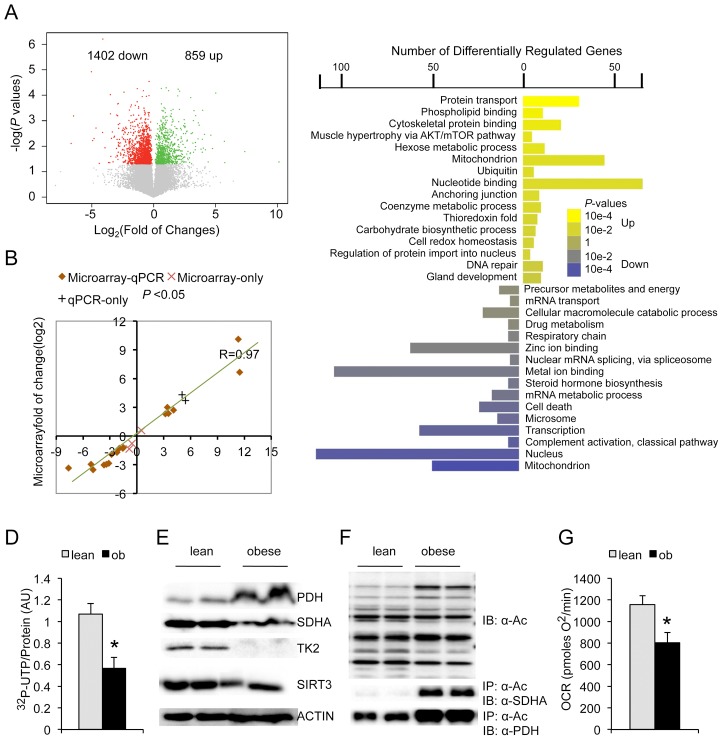
Genome-wide translational changes in the obese mouse liver.(A) Scatterplot of logP-values versus log2FC (fold of change, obese/lean). Green denotes genes up-regulated in the obese liver ER translatome while red denotes downregulation. (B) Differential regulation of transcripts as measured by microarray (Y-axis) and quantitative RT-PCR (X-axis) for 22 genes that were calculated as differentially regulated (student t-test, P<0.05) by either one or both methods. (C) Gene Ontology analysis of differentially regulated genes in the ER translatome of nonfasted lean and obese liver. X-axis denotes the number of genes categorized into each differentially-regulated function on the Y-axis. Color scale corresponds to logP-values converted to positive values for functional categories comprised of upregulated (obese/lean) genes. (D) Measurement of RNA synthesis in lean and obese primary hepatocytes based on 32P-UTP incorporation (t = 2 hours, n = 4, p<0.01, Student's t-test). (E) Immunoblot measurement of mitochondria protein expressions in the lean and obse mouse liver samples. (F) Immunoblot measurement of overall mitochondrial protein acetylation (IB: α-Ac, top panel) and the acetylation of the succinate dehydrogenase (IP: α-Ac; IB: α-SDHA, middle panel). Acetylation of the pyruvate dehydrogenase enzyme 1 (PDH-E1α) is shown (bottom panel) as a positive control for α-Ac immunoprecipitation as it is fully charged with acetyl-CoA under both lean and obese conditions. (G) Measurement of mitochondria oxygen consumption rate (OCR) for lean and obese primary hepatocytes (n = 7, p = 0.01, Student's t-test).